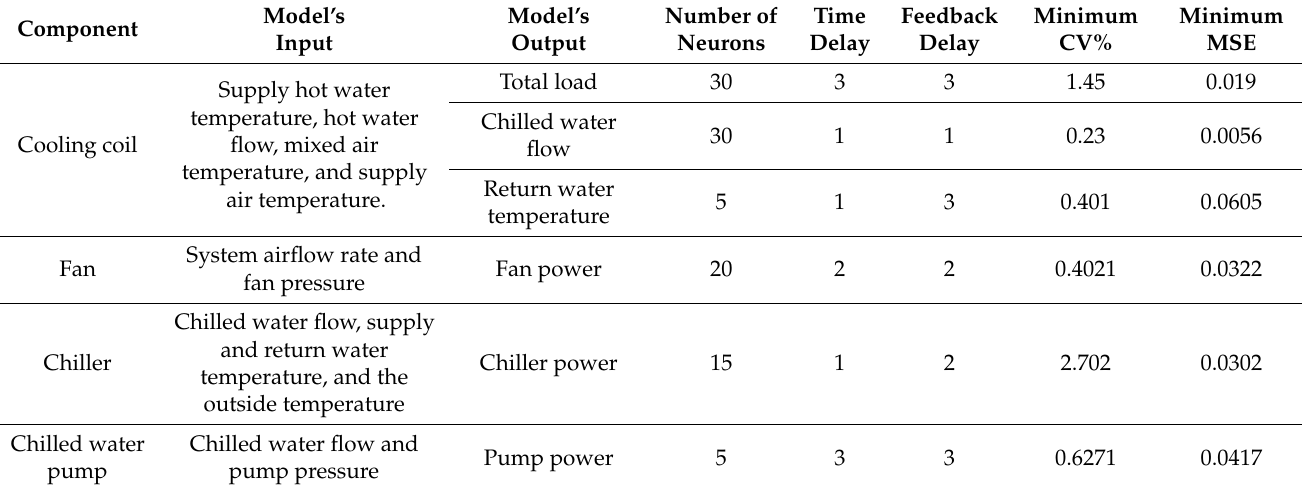
Table 1. Optimization Process Results for the chilled water VAV system